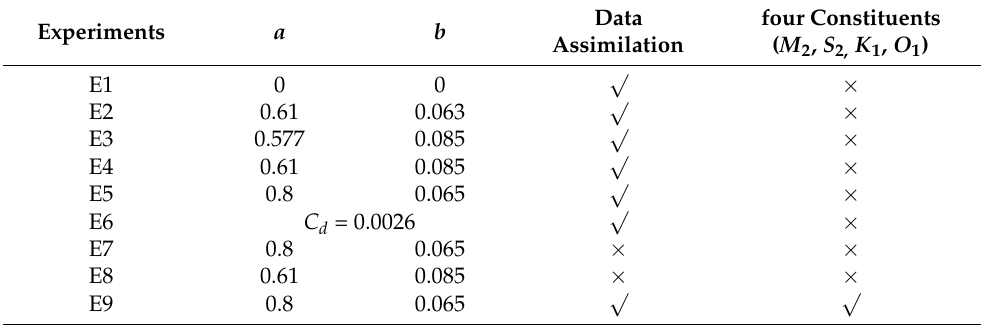
Table 3. Experiments evaluating the effect of initial values of a and b in the expression C d , data assimilation method and four constituents ( M 2 , S 2 , K 1 , O 1 ) on the storm surge